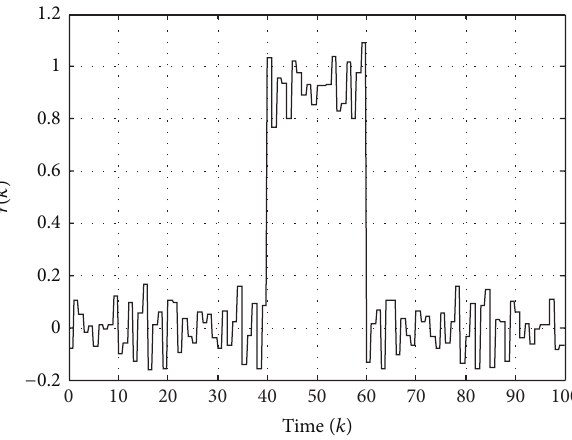
Figure 1: Residual signal 𝑟(𝑘) when 𝜌 = 1 and 𝐷 𝑓 (𝑘) = 1.8 .